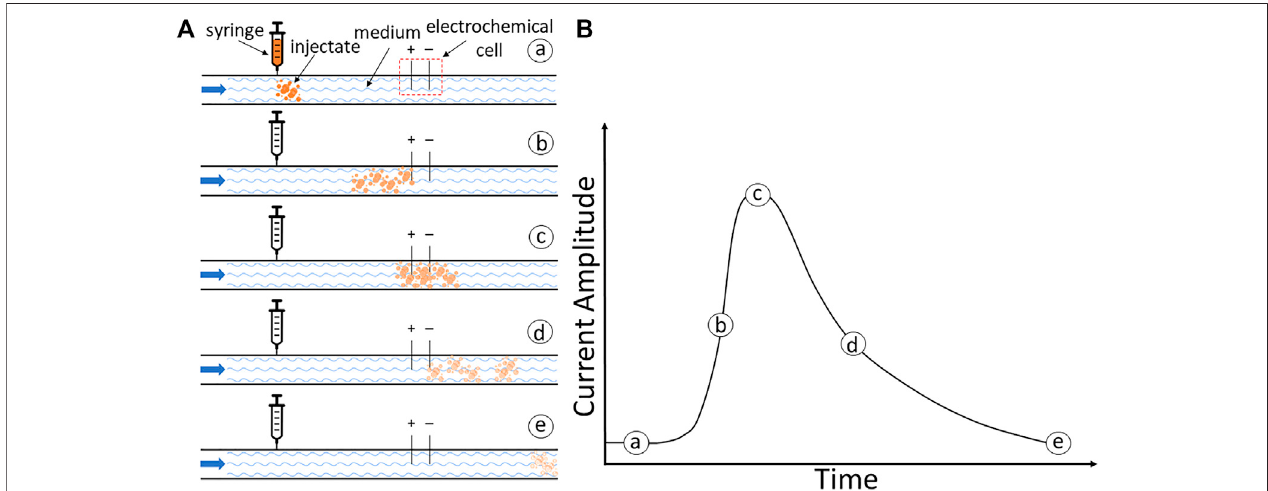
FIGURE 1 | (A) Schematic illustration of the electrodilution principle. (A) Injection of tracer. (B) Initiation of the current response as the mixture reaches the electrochemical cell. (C) Peak response to the injectate mixture. (D) Dilution by the continued fl ow of the medium. (E) Return to the baseline. (B) A model current time response with